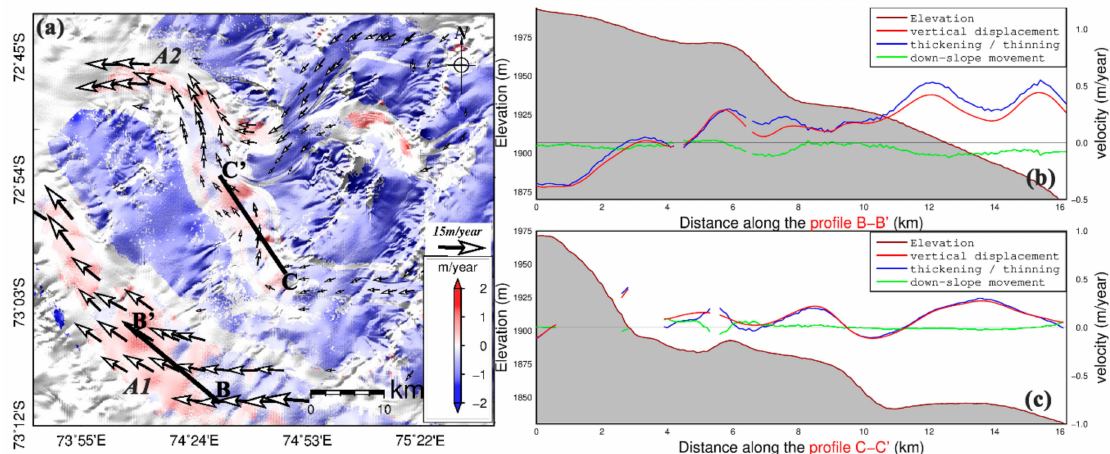
Figure 9. Ice thickening or thinning derived from the 3D ice velocities ( a ). The vertical (red line), downslope (green line), and thickening (blue line) displacement along the profiles of B-B’ ( b ) and C-C’ ( c ) are shown. The coverage is shown as a black rectangle in Figure 6a.